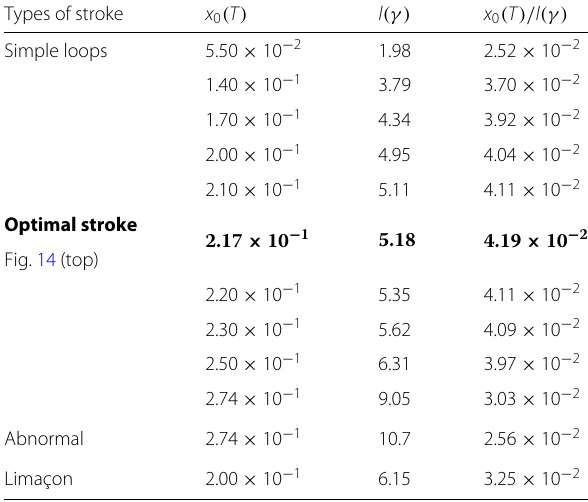
Table 2 Geometric efficiency for the abnormal stroke and different normal strokes with the Euclidean cost Types of stroke x 0 ( T ) Simple loops